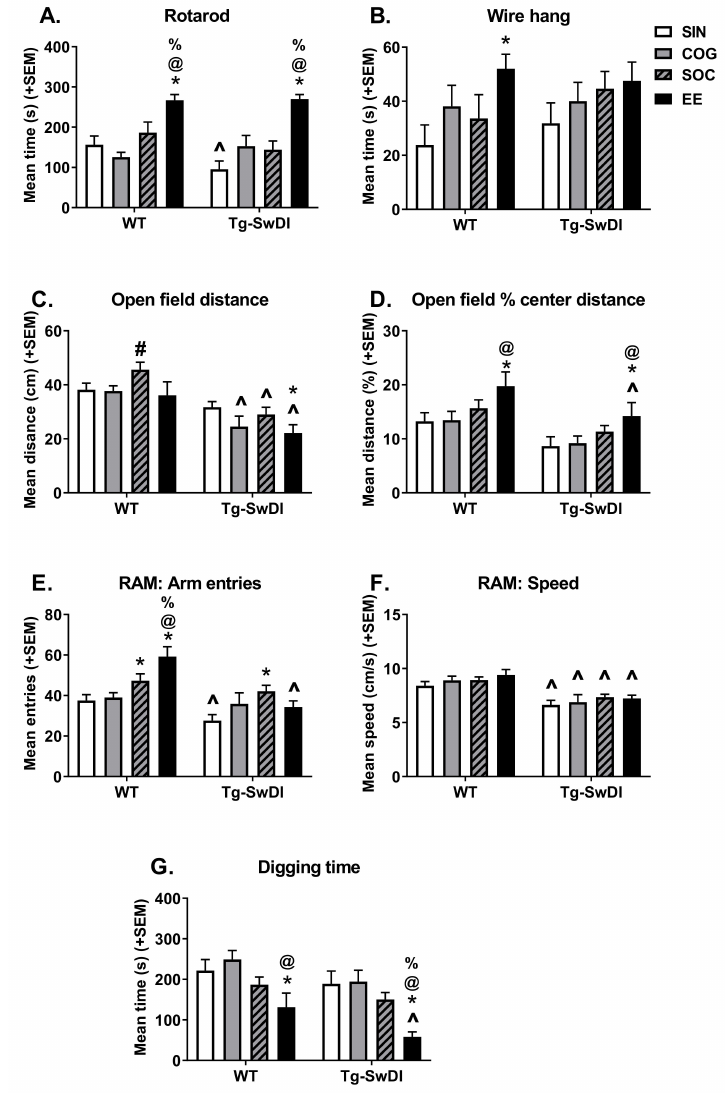
Figure 4. Activity and temperament measures. ( A ) Rotarod performance measured by time spent on rod (average of best two of three trials), indicative of balance and motor coordination. Under SIN conditions, Tg-SwDI mice were impaired in this task, while EE housing improved performance in both WT and Tg-SwDI mice. ( B ) Wire hang performance measured by time spent hanging onto a wire, indicative of forelimb strength. EE housing improved performance, but this was only significant in WT mice. ( C ) General activity levels, as measured by the distance traveled in the open field. SOC housing increased activity in WT mice. Overall, Tg-SwDI mice were hypoactive and this was exacerbated in EE mice. ( D ) Anxiety-like behavior, as measured by the percent of distance traveled in the center of the open field arena. Overall, Tg-SwDI mice exhibited increased anxiety-like behavior (less center activity), while anxiety was reduced by EE housing in both WT and Tg-SwDI mice. E and F) Exploratory behavior, as measured by the number of arm entries ( E ) and speed of travel ( F ) in the radial arm maze task. Generally, Tg-SwDI mice exhibited lower levels of exploration, and the number of arm entries was increased in SOC mice. In WT mice, SOC and EE housing increased the number of arm entries as well. ( G ) Time spent digging in a marble-burying task. Generally, Tg-SwDI mice exhibited lower levels of digging behavior, while EE housing attenuated digging behavior in both WT and Tg-SwDI mice. * p < 0.05 vs. SIN of the same genotype, @ p < 0.05 vs. COG of the same genotype, % p < 0.05 vs. SOC of the same genotype, # p < 0.05 vs. EE of the same genotype, ˆ p < 0.05 vs. WT in the same housing